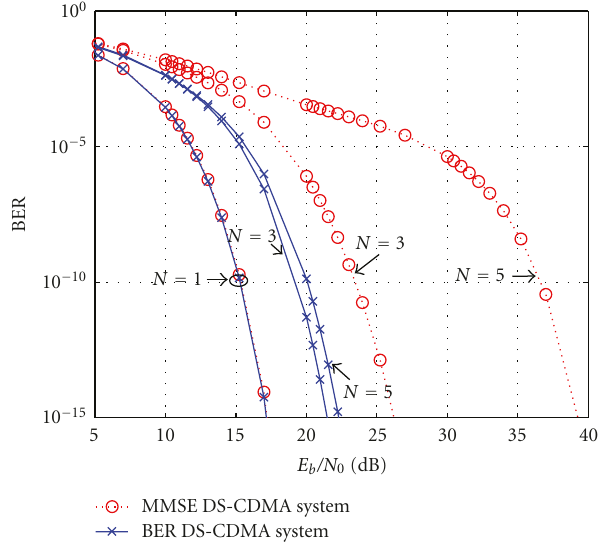
Figure 3: BER versus E b / N 0 performances of the MMSE DS- CDMA system ( ··· ◦ ··· ) and the proposed minimum BER DS- CDMA system ( − × − ) for di ff erent number of users N ∈ { 1,3,5 } , when M = 7, L = 5, and l = 0. When N increases, then the performance curves move